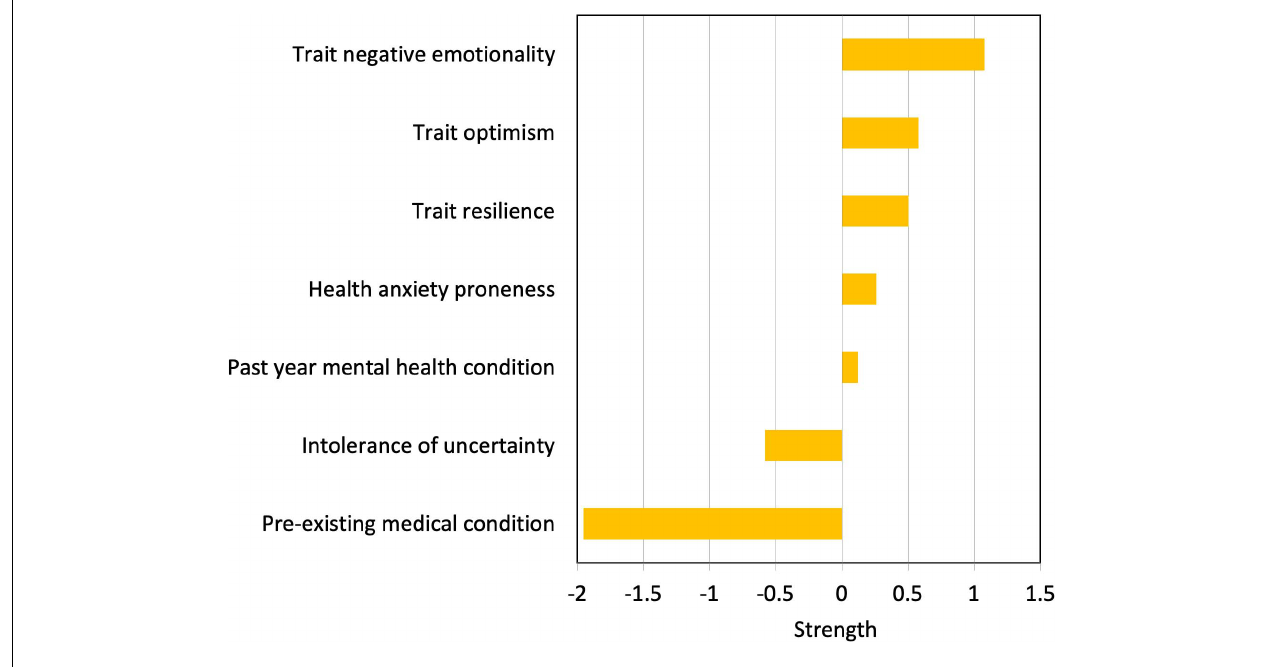
FIGURE 2 | Strength of connection among nodes representing vulnerability factors.